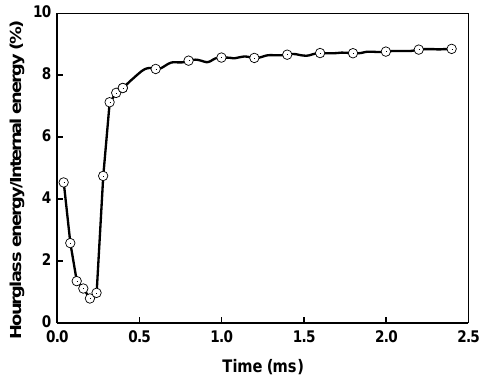
Figure 10. Ratio of hourglass energy to total energy.